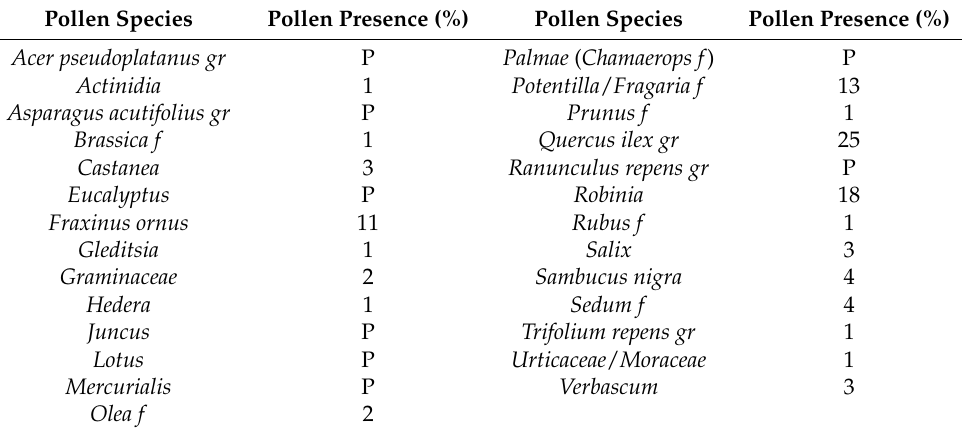
Note: gr = group; f = form; P = pollen presence but with a percentage lower than